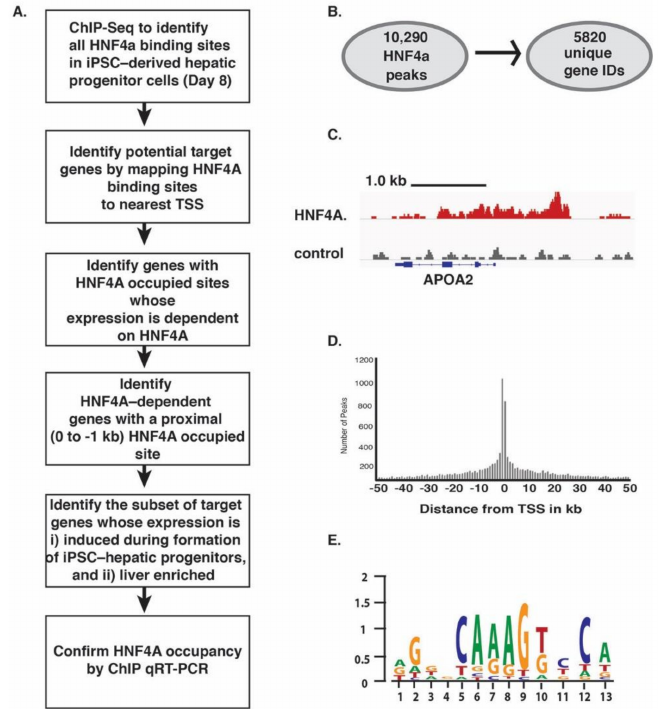
Figure 4. Identification of HNF4A bound sites in iPSC-derived hepatic progenitor cells. ( A ) Strategy used to identify direct targets of HNF4A during the formation of the hepatic lineage from iPSCs; ( B ) Summary of the number of targets identified by ChIP-seq analyses; ( C ) Example of HNF4A enriched sequences (peaks) in the Apo2 gene; ( D ) Distribution of HNF4A peaks relative to the transcriptional start site of the nearest known gene; ( E ) Consensus HNF4A binding site determined from analyses of all